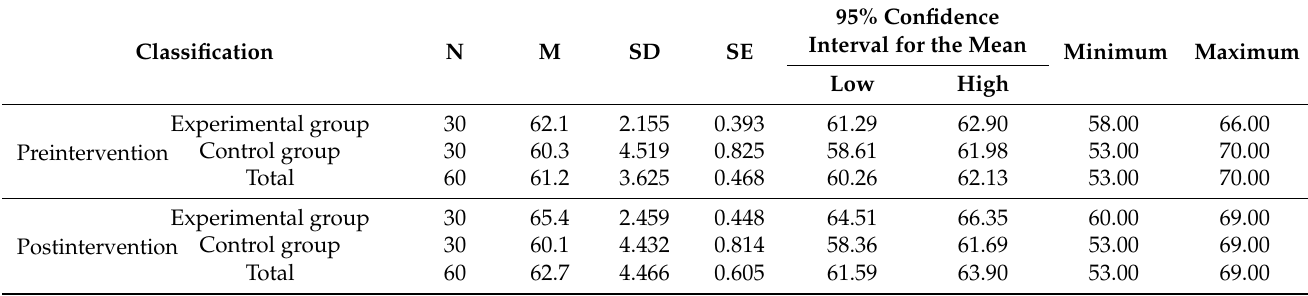
Table 3. Results of descriptive statistics of differences between pre-/post-group.